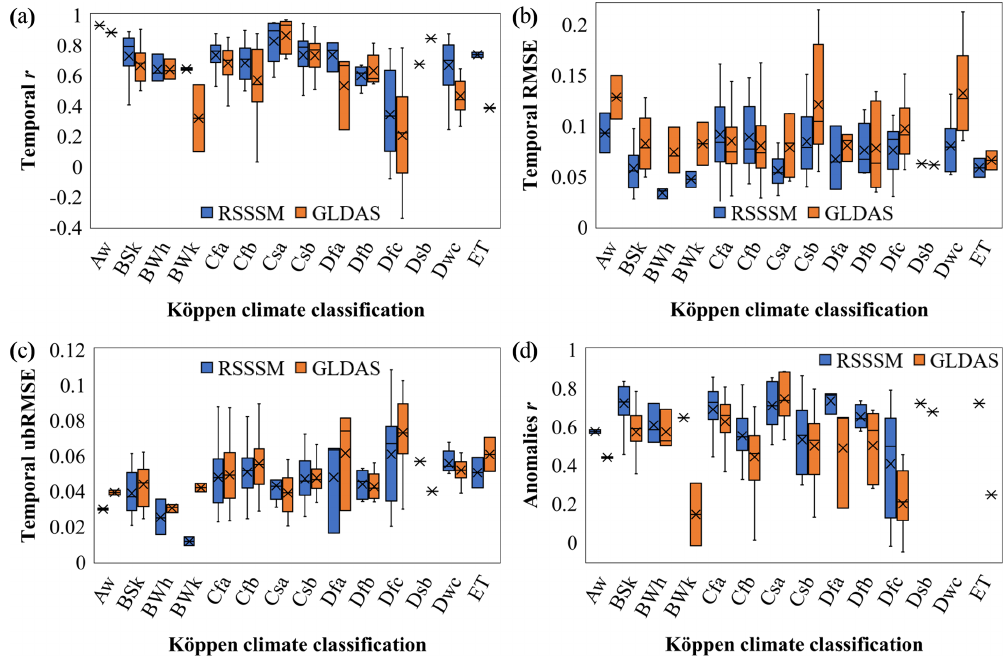
Figure 11. Comparison of the temporal accuracy between RSSSM and GLDAS surface soil moisture in regions with different Köppen– Geiger climate types. The four indexes are (a) r , (b) RMSE, (c) ubRMSE, and (d) Anomalies r